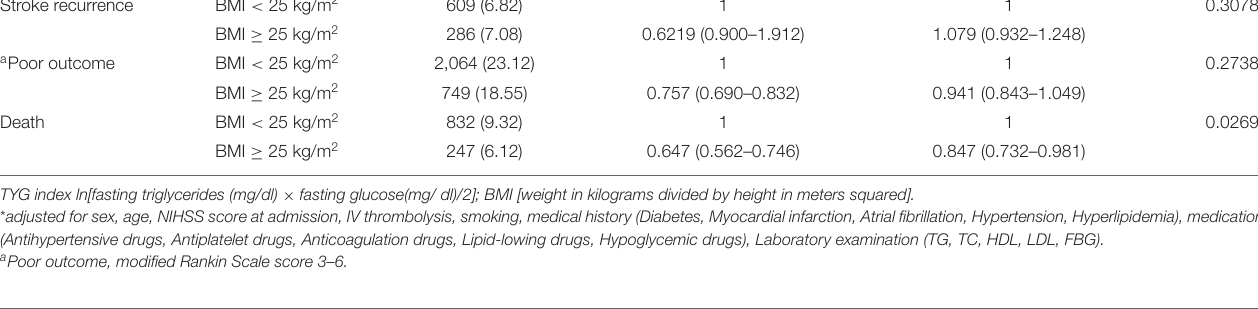
TABLE 3 | Association between BMI and stroke outcomes stratified by TYG index.